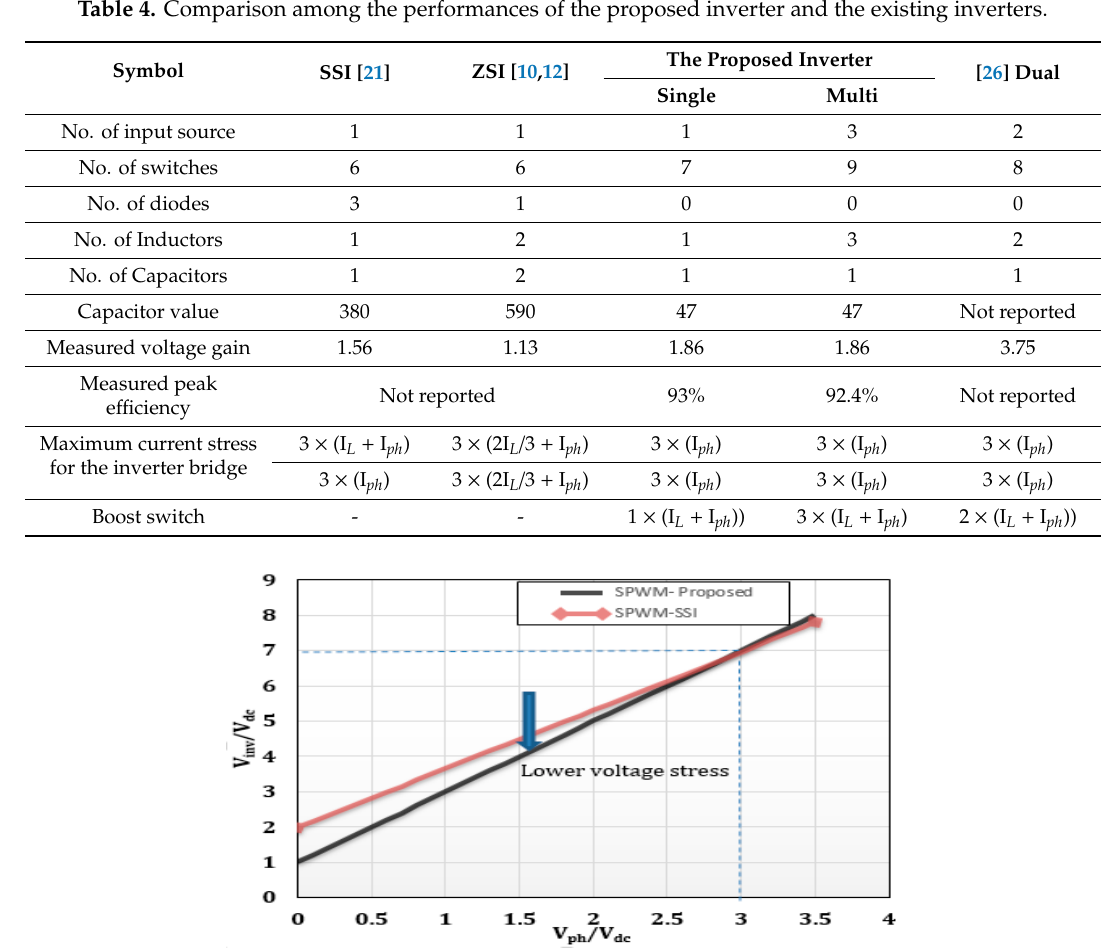
Table 4. Comparison among the performances of the proposed inverter and the existing inverters.